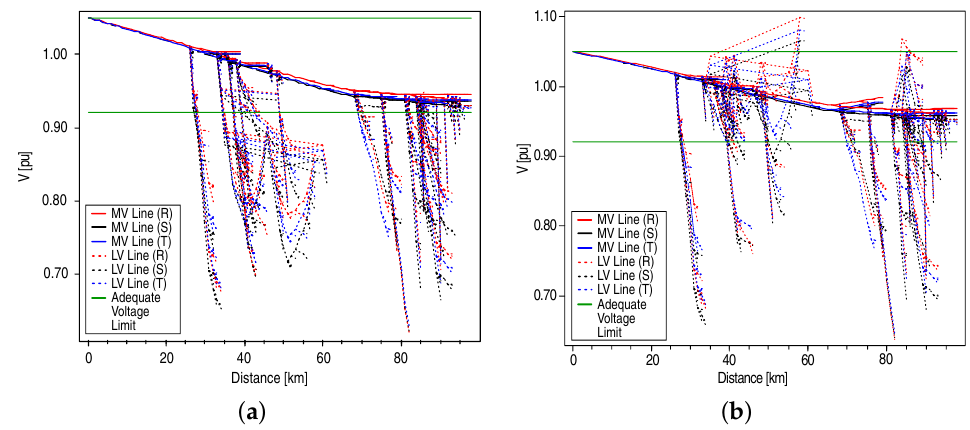
Figure 30. Result of the optimization of variables pos and pot with bar constraint: ( a ) voltage profile before allocations and ( b ) voltage profile after